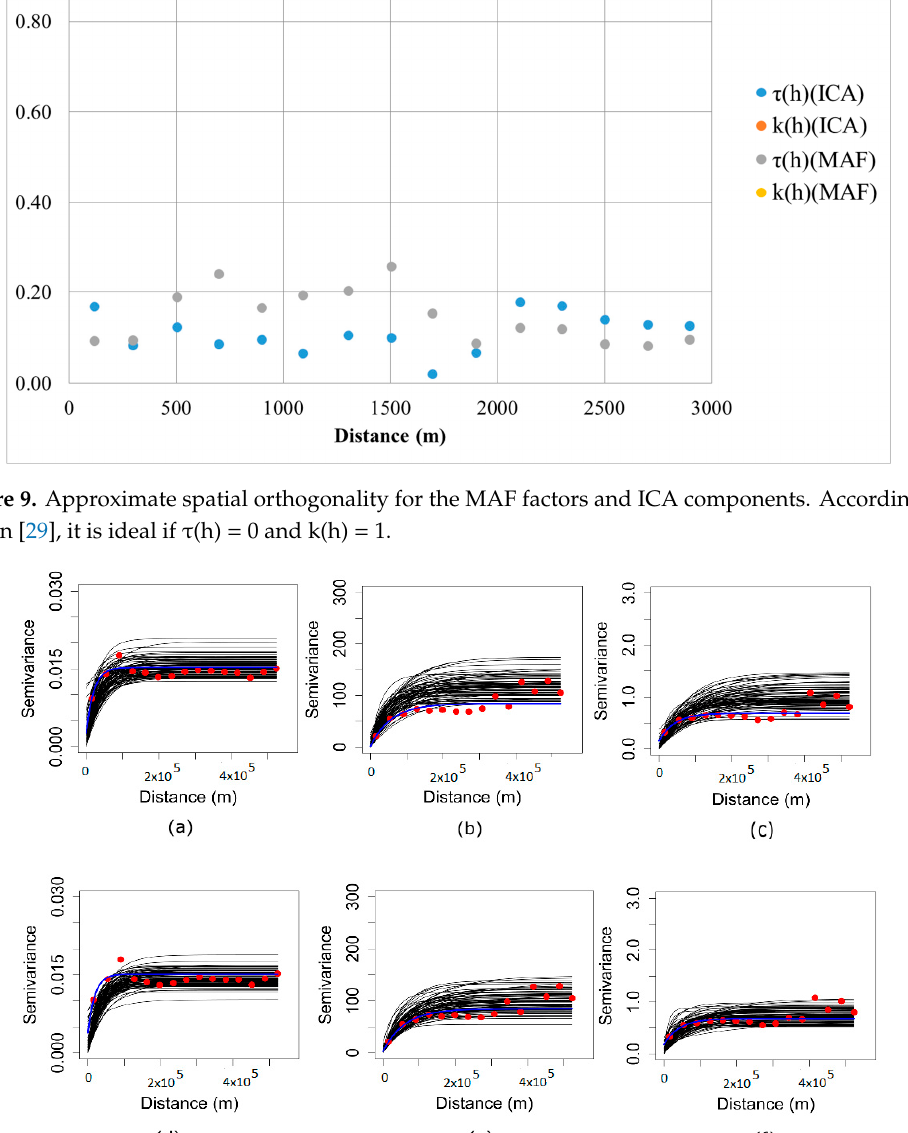
Figure 10. Direct variograms of 100 realizations (black solid lines) for soil health indicators (SHIs), using MAF (first row) and ICA (second row) together with that of ( a , d ) original bulk density (g/cm 3 ) (red dots); original organic matter (g/kg) ( b , e ) (red dots); original total nitrogen (g/kg) ( c , f ) (red dots). Solid blue line denotes the fitted exponential covariance function of original data. Semivariance is expressed in units of each SHI.